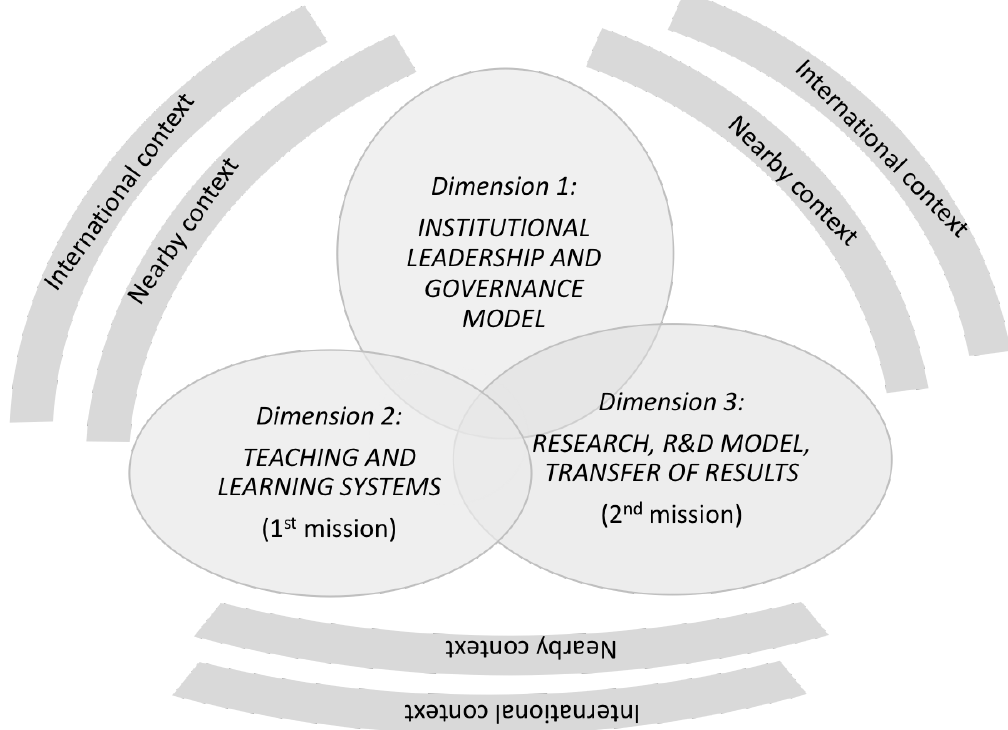
Fig. 3. Key areas of the profile of an IU. SOURCE: developed by the